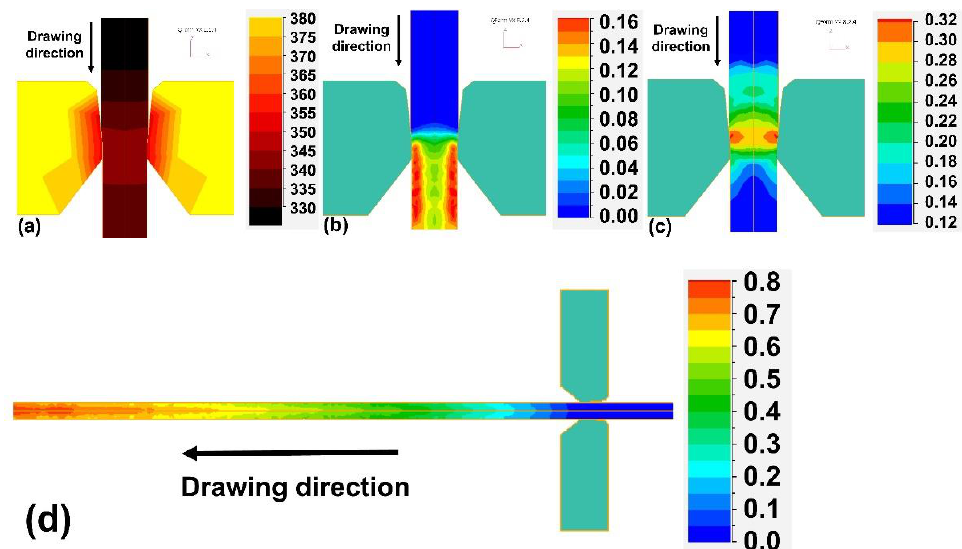
Figure 5. Results of the FE simulation of hot-drawing variant t440: the distribution of temperature in the deformation zone and hot die ( a ); effective plastic true strain ( b ); critical deformation, calculated by Equation (5) ( c ); and the static recrystallized volume fraction after the pass ( d ). Data for the first pass from Table 1.